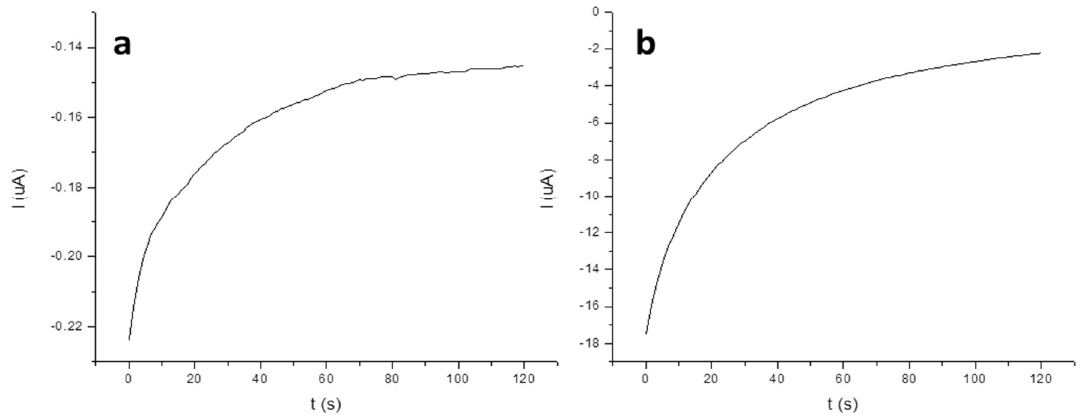
Figure 4. Chronoamperograms obtained for the deposition step of 5 µg L −1 Hg at 0 V for 120 s with ( a ) SGE and ( b ) AuNPs‐GCE.